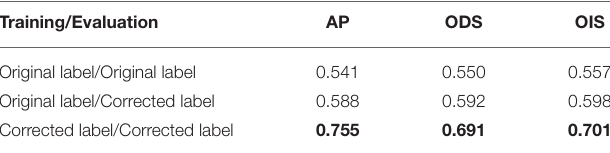
TABLE 4 | Performance improvement analysis of label correction.